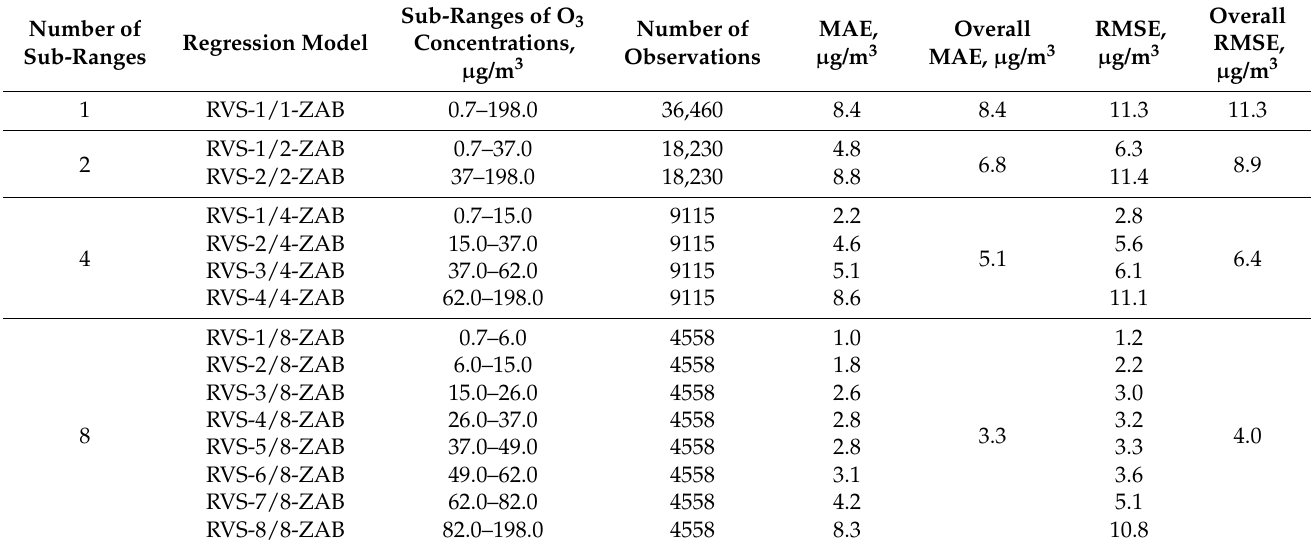
Table 5. Values of approximation errors of O 3 concentrations in RVS models, Zabrze 2011–2016.